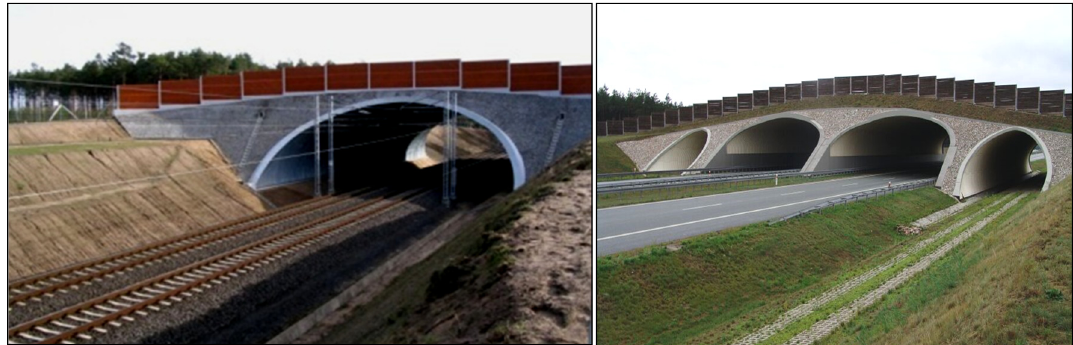
Figure 11. Railway and road wildlife crossings in Poland (Photo: A. Czerniak).